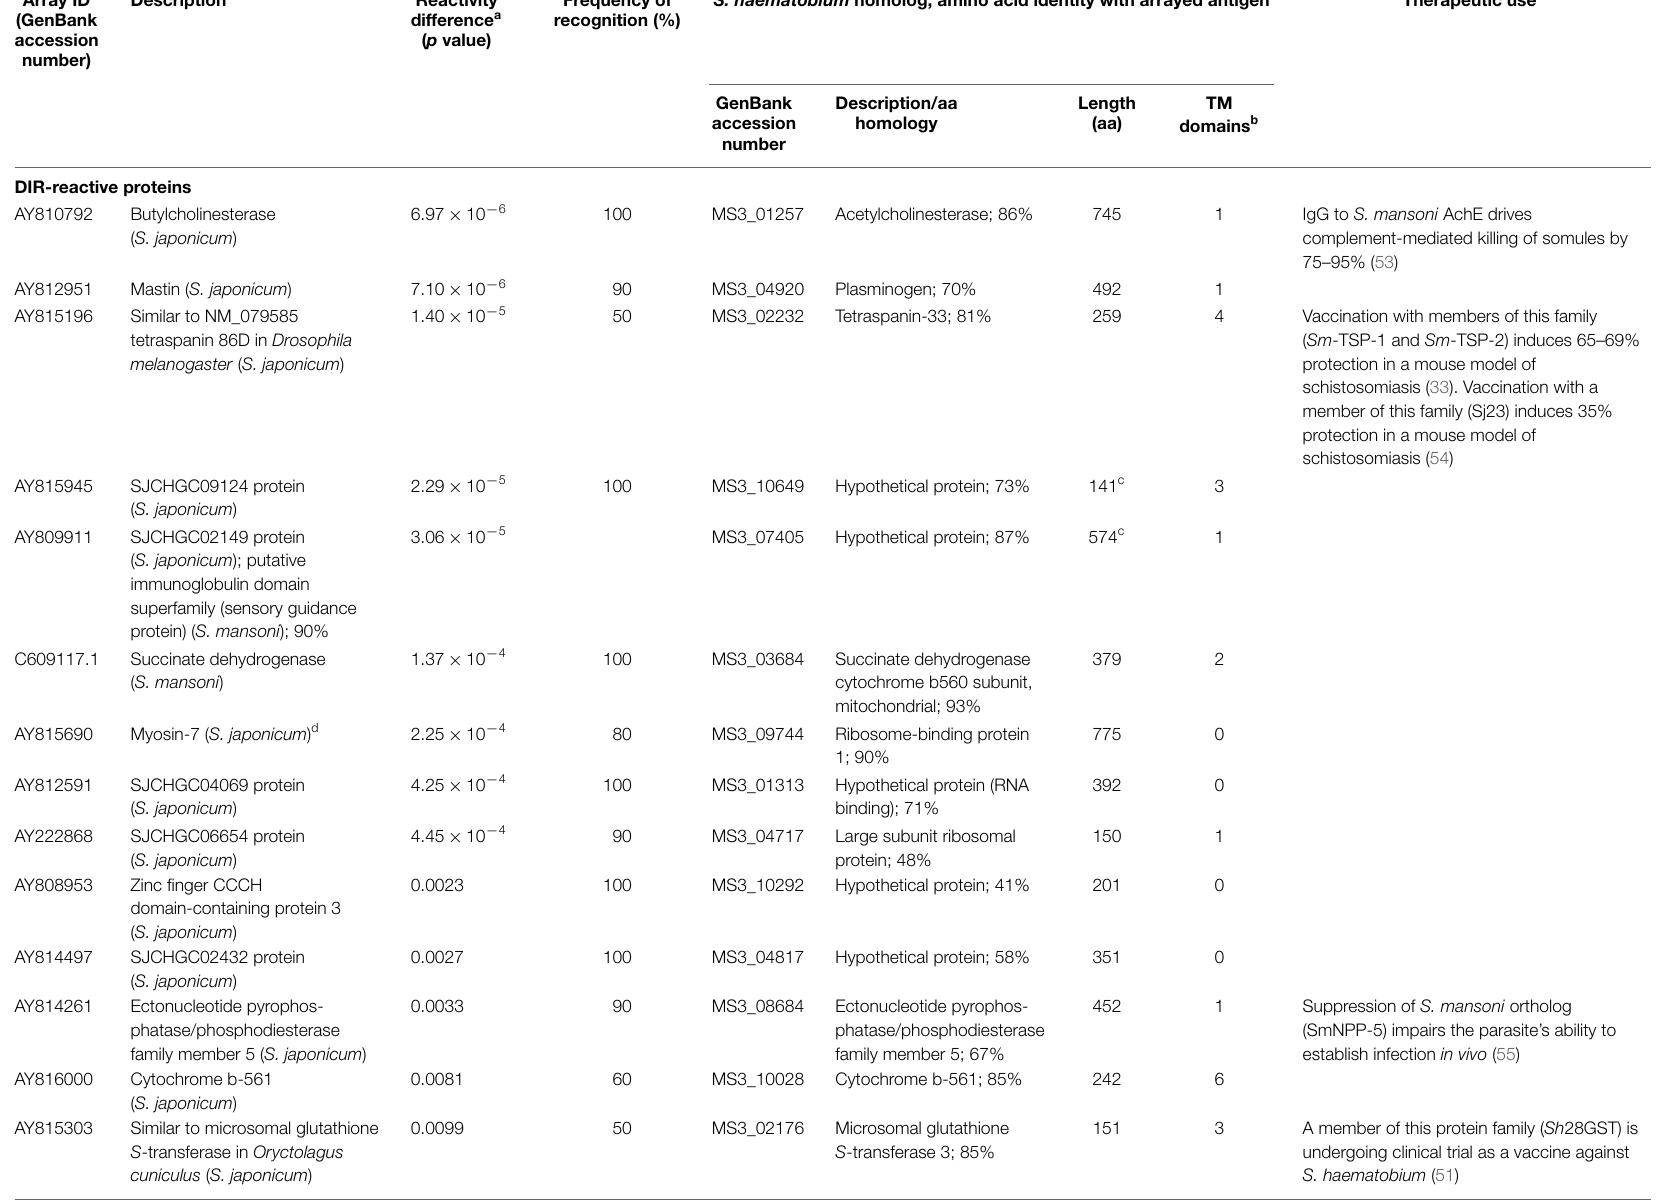
TABLE 1 | Arrayed proteins significantly reactive to S. haematobium -infected DIR post-treatment sera and S. japonicum -infected, self-curing rhesus macaque sera . Array ID